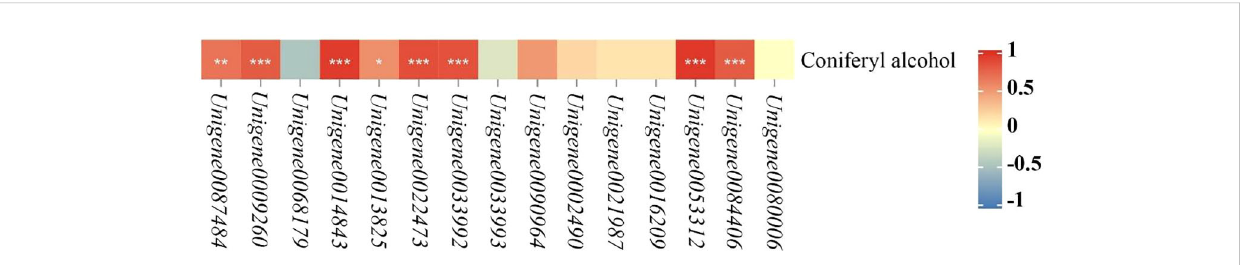
FIGURE 6 Heatmap analysis of the correlation between POD activity-related genes and Coniferyl alcohol. (In the phenylpropanoid biosynthesis pathway, heat map analysis of the correlation between 15 POD activity-related genes and coniferyl alcohol were generated. p ≥ 0.05 is not marked; 0.01 < p < 0.05 is marked as *0.001 < p < 0.01 is marked as ** p ≤ 0.001 is marked as